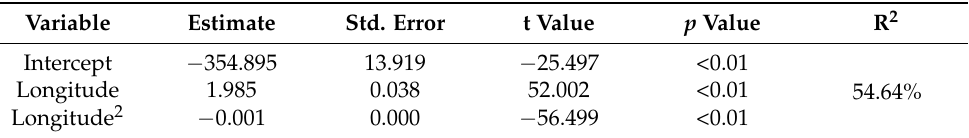
Table 2. Results of the multiple regression adjustment for the number of days without rain in the State of Para í ba in the period from 1994 to